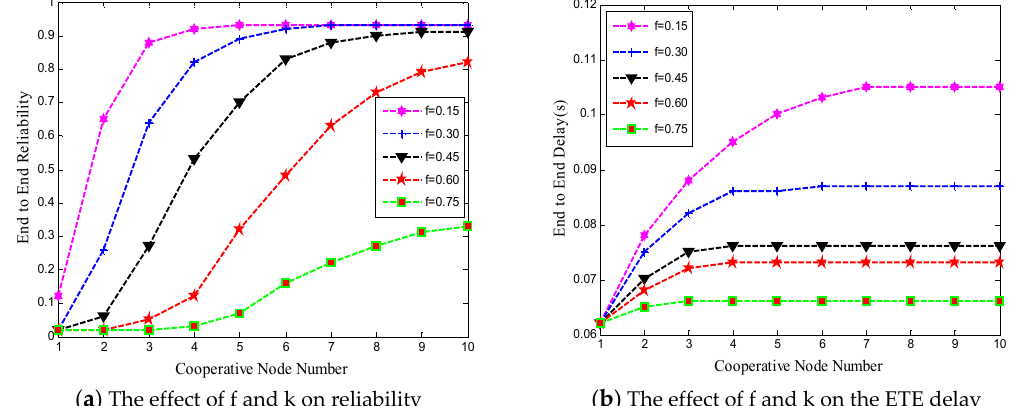
Figure 7. Effect of f and k on end-to-end reliability. Figure 7. E ff ect of f and k on end-to-end